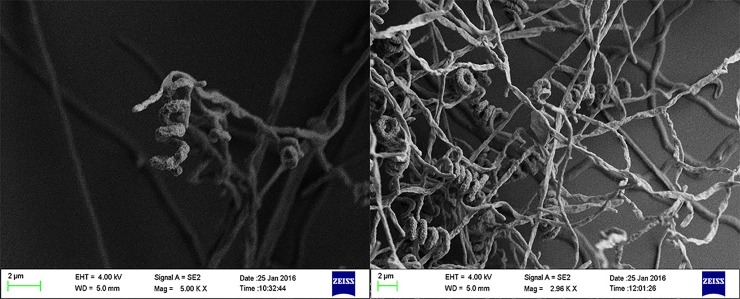
Scanning electron mirographs of strain 1–14.